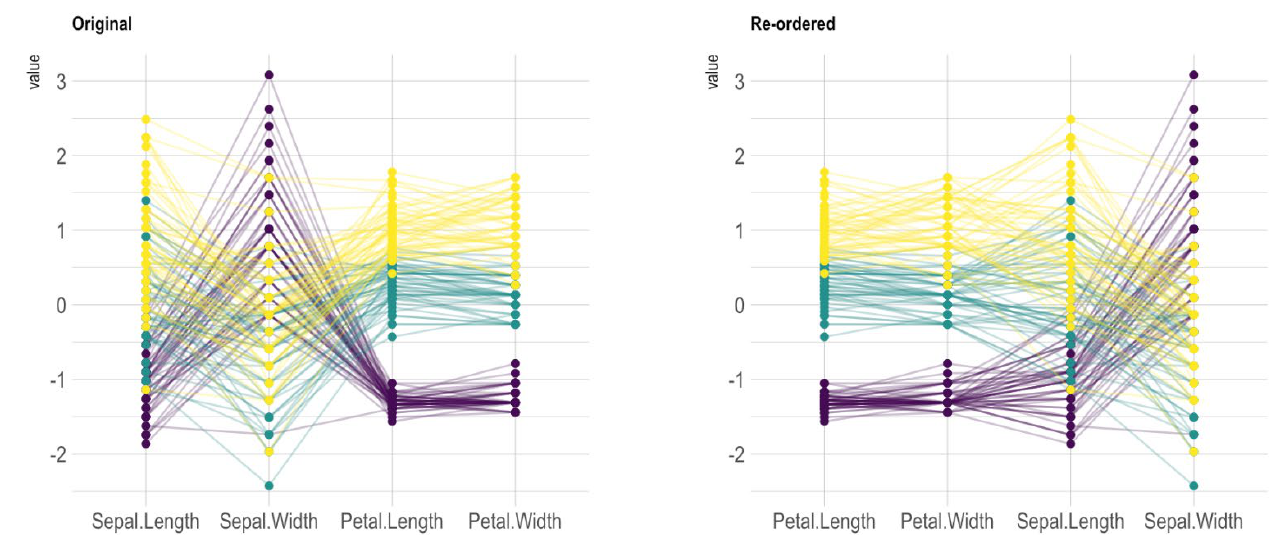
Figure 2. PCP of three Iris species. Samples grouping highlighted efficiently that setosa has smaller Petals, but its sepal tends to be wider (The graphs obtained from Data-to-vis.com)